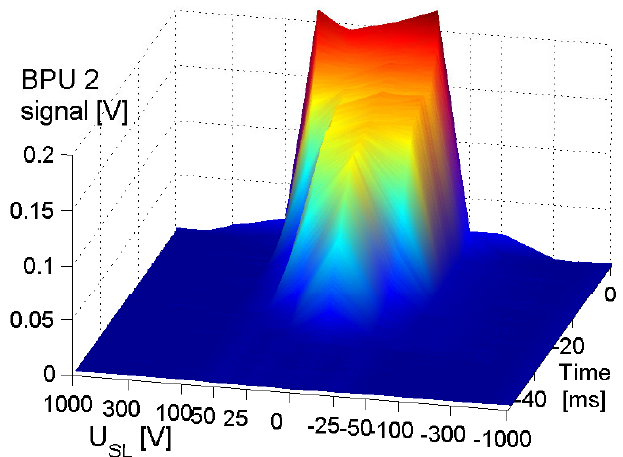
FIG. 9. (Color) Electron cloud button pickup #2 signal measured in SS98 for the nominal LHC beam. The color-coded signal height varies as a function of applied voltage on the clearing electrode and with time, no magnetic field was applied. The last 50 ms before ejection are shown.